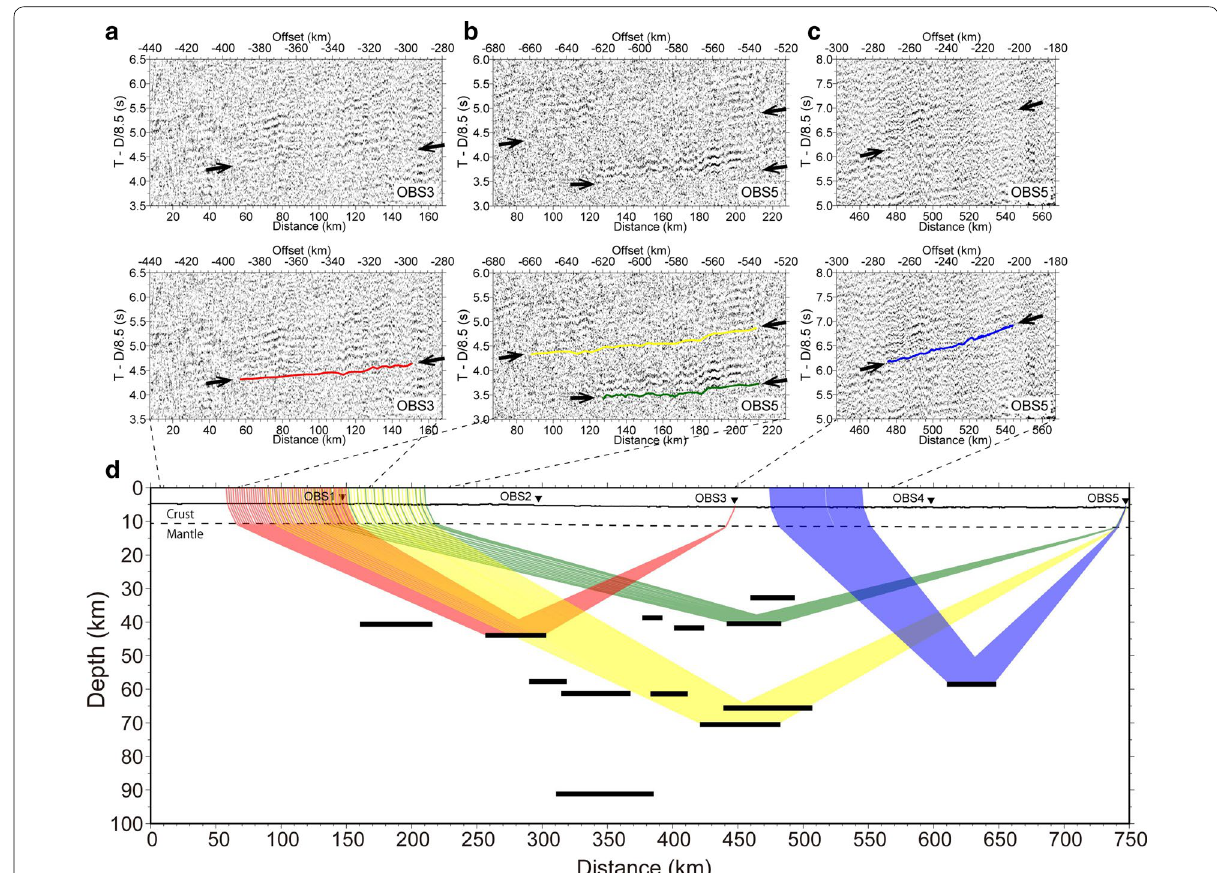
Fig. 12 a – c Close-ups of OBS3 and OSB5 record sections (see Fig. 6a). Arrows indicate wide-angle reflection phases (DRs) at large offsets. The travel times calculated from the 2-D ray tracing are superimposed on the record sections in the bottom panels. Reduction velocity is 8.5 km/s. Pn indicates refraction phases from the uppermost mantle. d Ray diagram for each DR. Black bars indicate reflection points